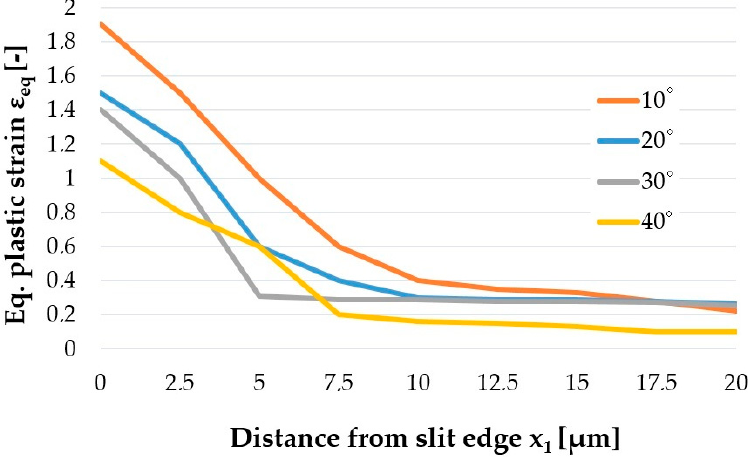
Figure 8. Effect of horizontal clearance c h on the equivalent plastic strain generated on cut edge.